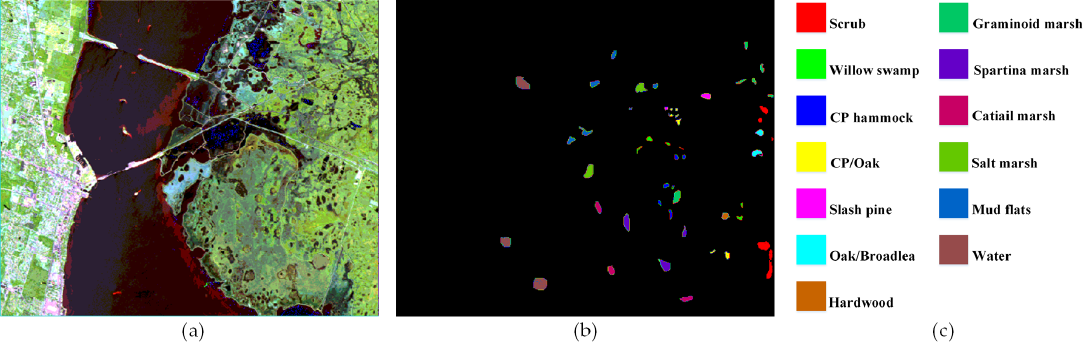
Figure 8. ( a ) False-color image, ( b ) Ground-truth image, and ( c ) Labels of the KSC dataset. Table 2. Land cover class information for the KSC dataset.